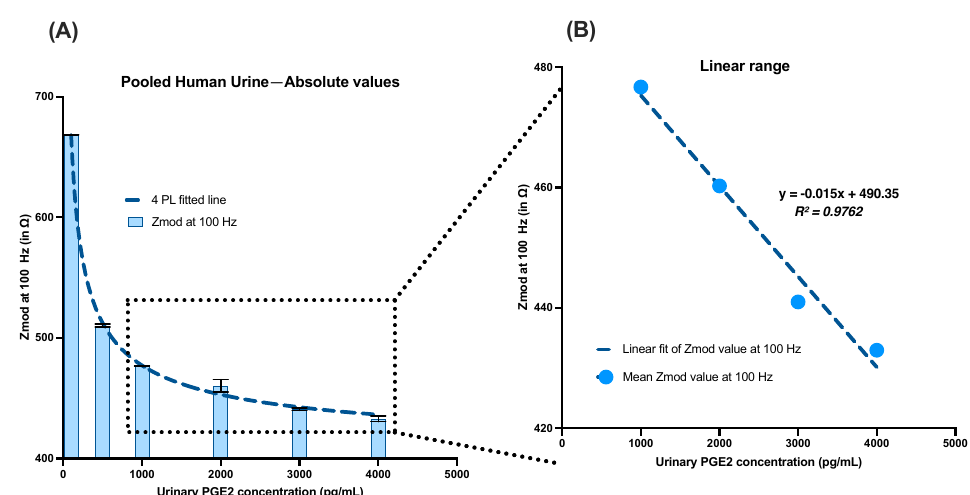
Figure 4. ( A ) Calibrated dose response curve for sensor response in pooled human urine using absolute Zmod values at 100 Hz (4 PL sigmoidal fitting) and ( B ) Calibrated dose response for linear operable range (linear fitting).